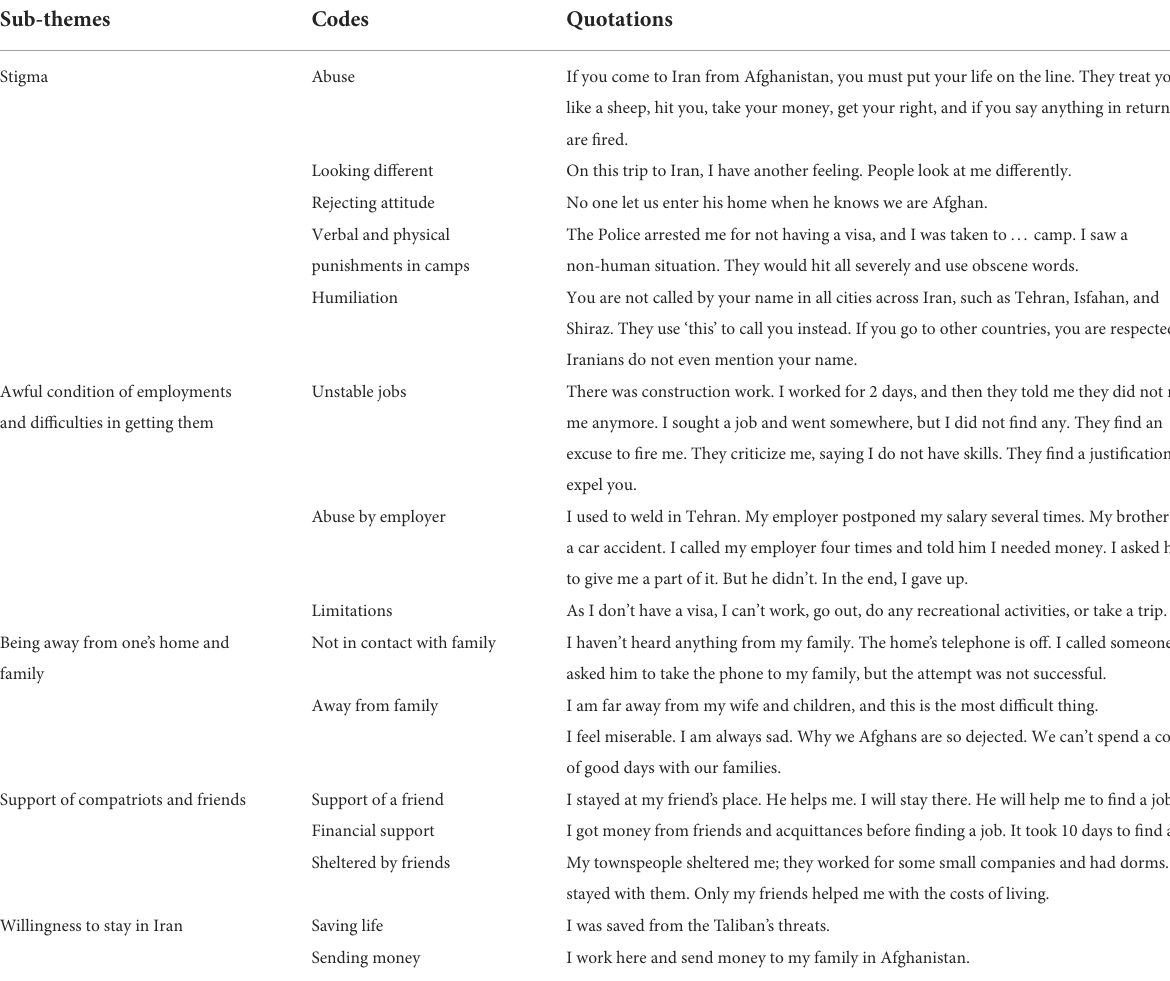
TABLE 3 Sub-themes, codes and quotations of the From Being a Citizen to Being a Refugee